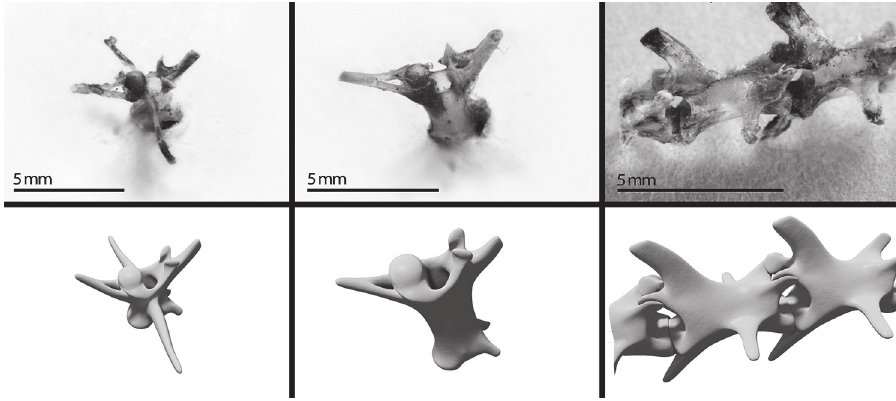
Figure 1 - Tropidurus itambere vertebrae photographs and the respective volumetric models they